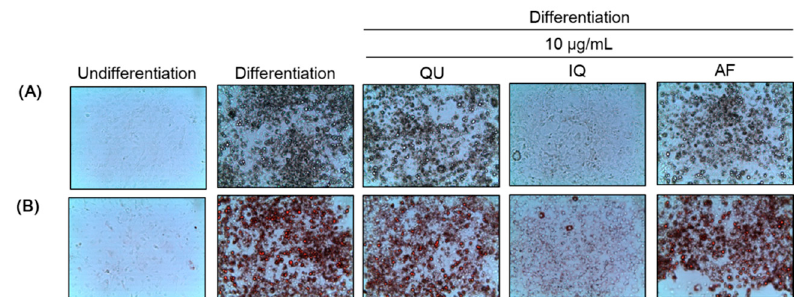
Figure 1. Effects of flavonoids from Acer okamotoanum on the cell viability in 3T3-L1 adipocytes. The 3T3-L1 adipocytes were pretreated with various concentrations (1–10 µg/mL) of flavonoids from A. okamotoanum for 72 h. Data are expressed as the mean ± standard deviation. NS: Non-significance; QU: Quercitrin; IQ: Isoquercitrin; AF: Afzelin.